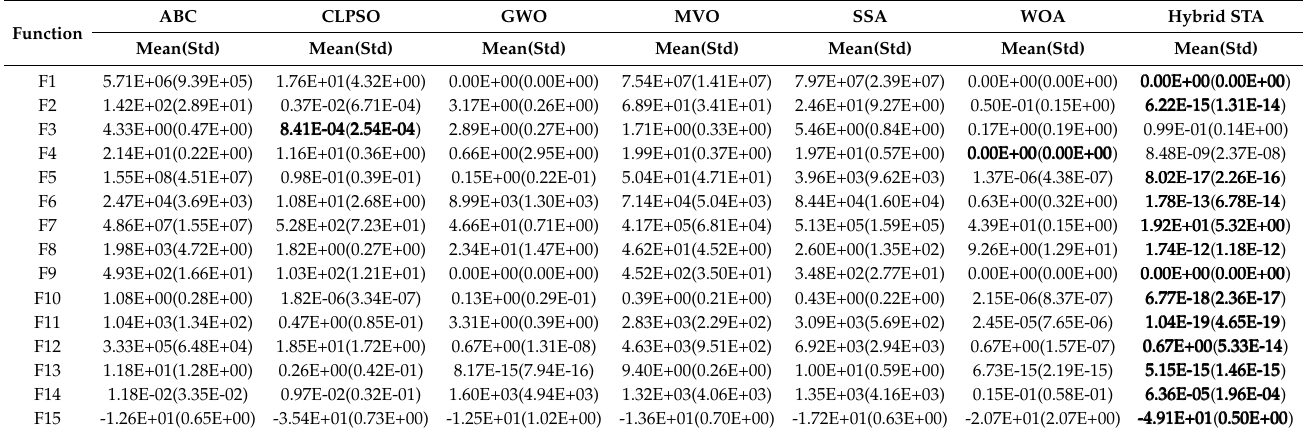
Table 5. Statistical results for different metaheuristic methods with D = 50.